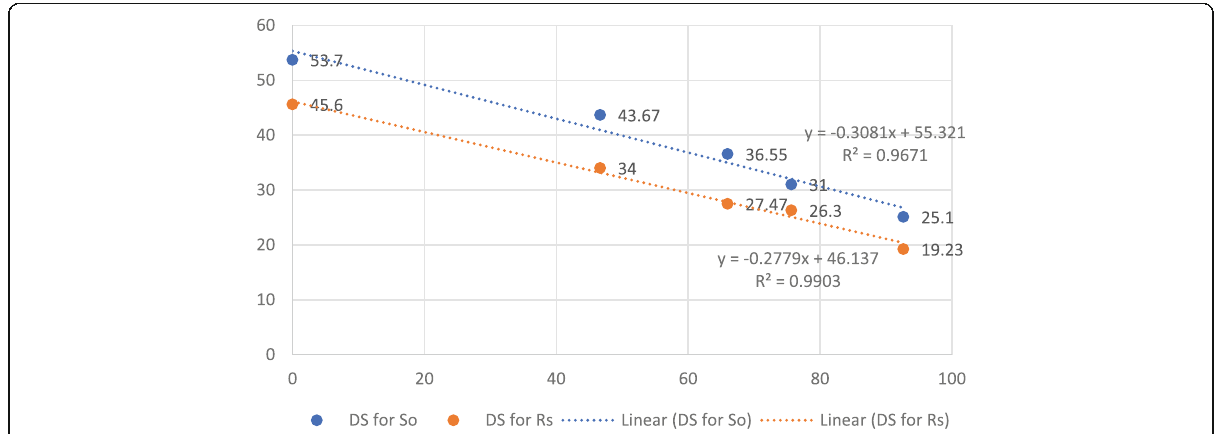
Fig. 1 Regression analysis of chlamydospore production of the selected isolates of Trichoderma and their antagonistic potential against R. solani and S. oryzae . Note: The X -axis represents the number of chlamydospores formed by selected four isolates. DS disease severity, So S. oryzae , Rs R.